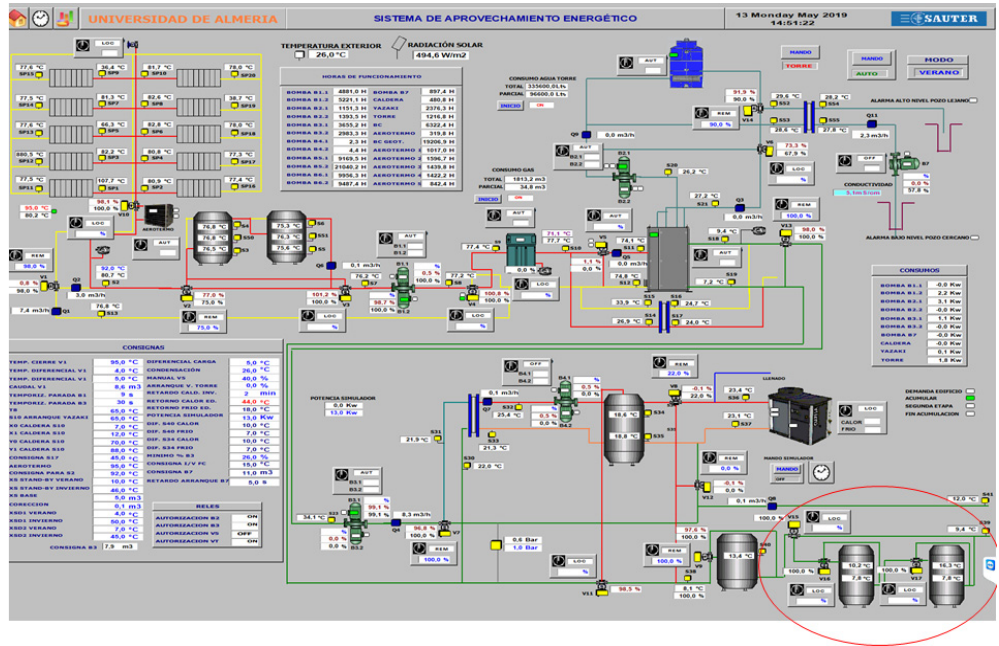
Figure 14. The main control panel of the SCH system with two PCM-based storage tanks.